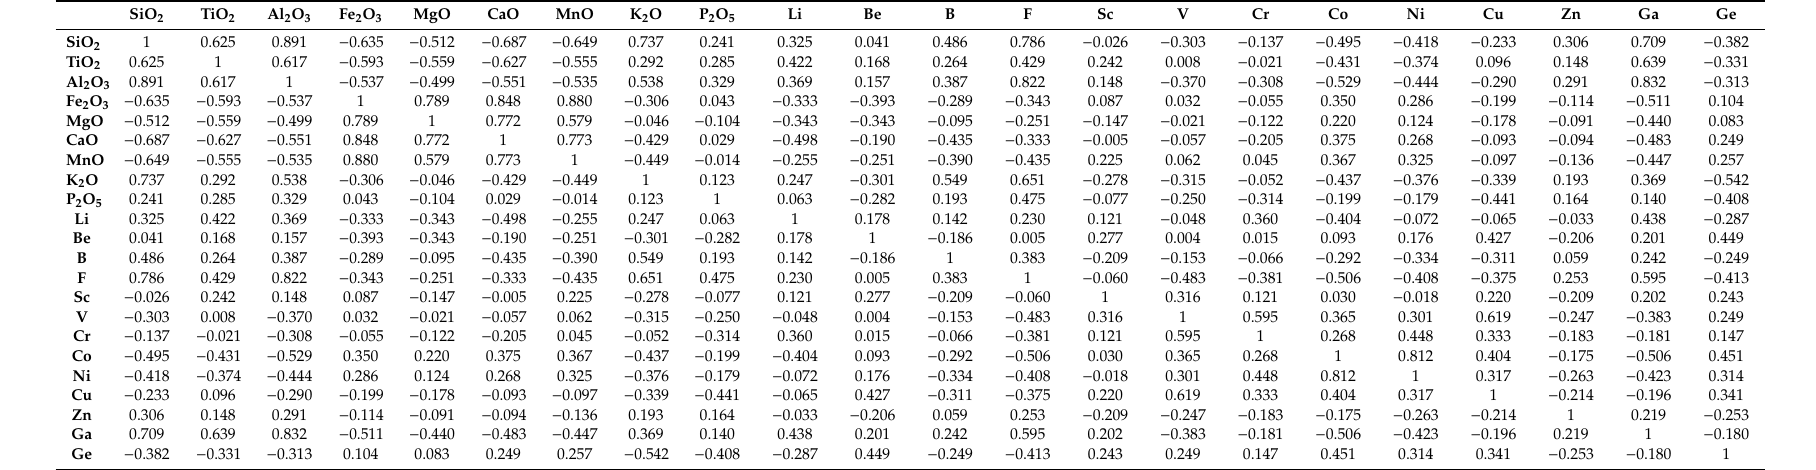
Table 3. Correlation using the clr approach on coal and ash basis (Datanhao